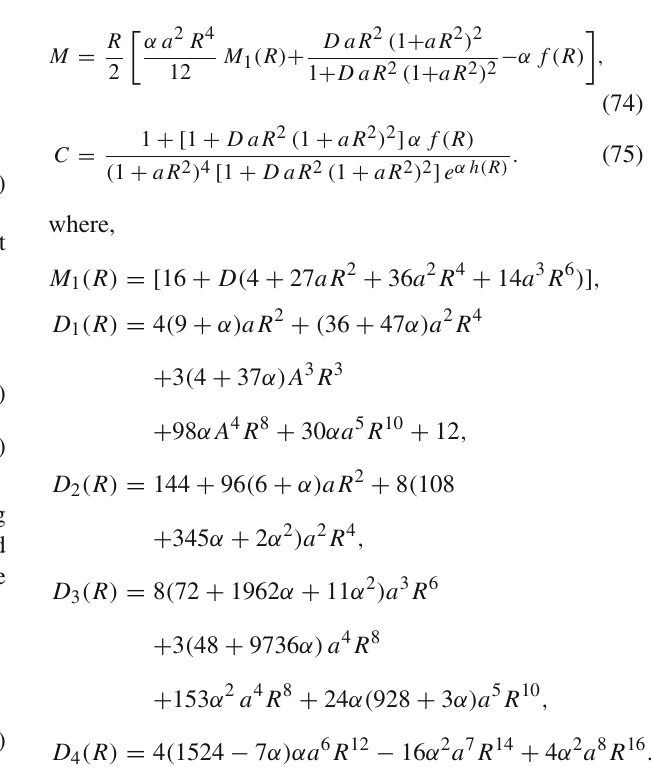
Fig. 3 The variation of pressures p eff r (top left), p eff t (top right), energy density ρ eff (bottom left) and anisotropy Δ eff (bottom right) verses radial coordinate r / R . For finding the trend of physical thermodynamic observable we have used same mass-radius ratio M / R = 0 .